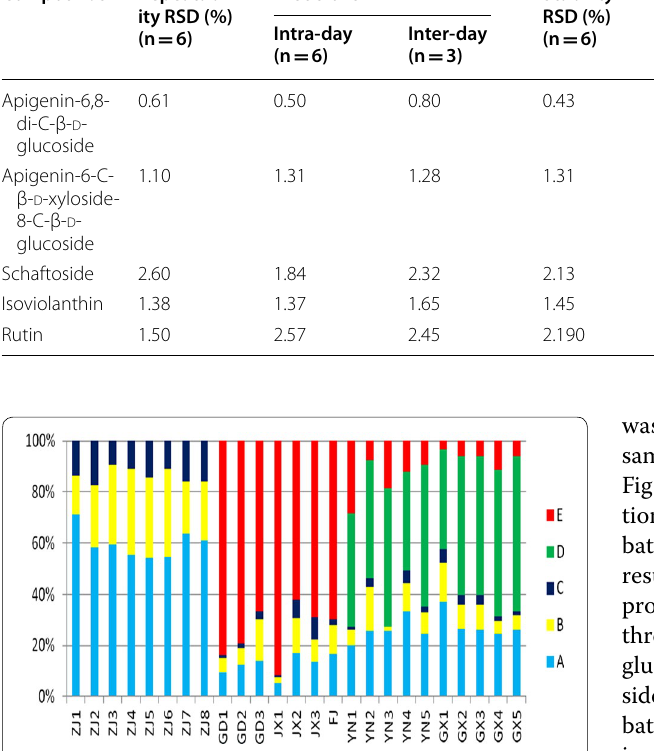
Table 3 Repeatability, intraday and interday precisions, and stability, recovery of 5 representative compounds from Den- drobium officinale Compounds